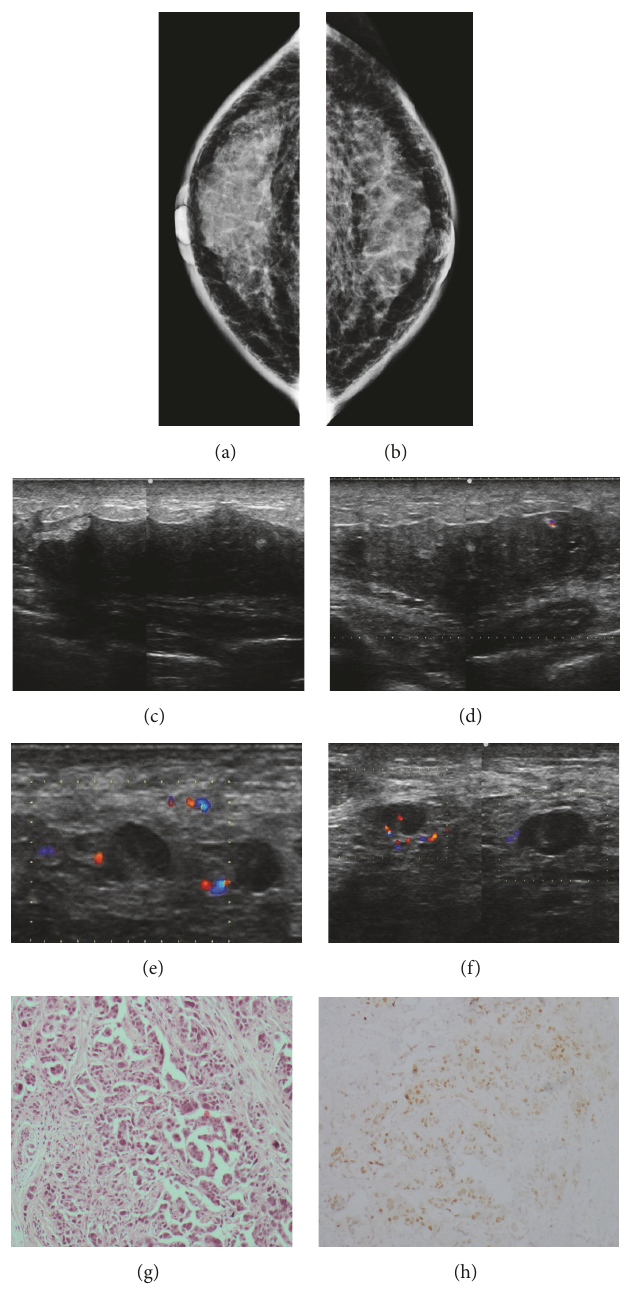
Figure 1: Case1. A 66-year-old-woman diagnosed with primary ovarian carcinoma with signet ring cells. On initial presentation, the patient showed breast lymphedema. Mammogram revealed abnormal skin enhancement, thickening, and edema consistent with inflammatory changes ( a–b ). Breast sonography exposed architectural distortions with a posterior combined pattern ( c–d ). Bilateral axillary lymph nodes with irregular cortical thickening were also found ( e–f ). Metastatic signet ring cell carcinoma to the breast was confirmed following a histopathological analysis of the breast and lymph node specimens. HE staining and immunohistochemistry analysis of the metastases. HE staining revealed the malignant cells in the breast tumor ( g ), and the immunohistochemistry analysis indicated that the cells were positive for PAX8 ( h